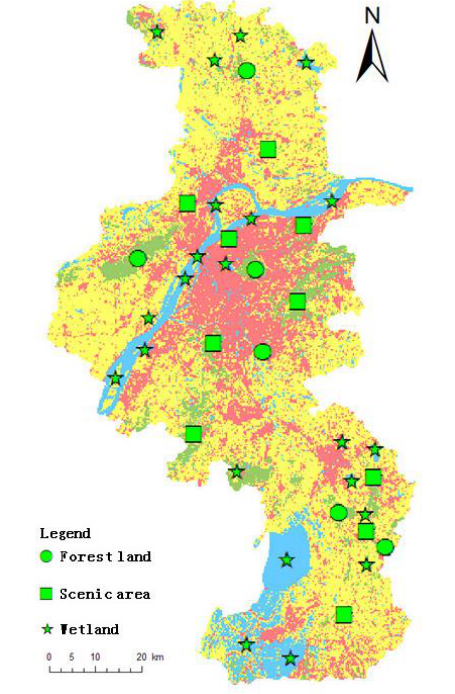
Figure 3. Distribution of ecological nodes of 2010 in